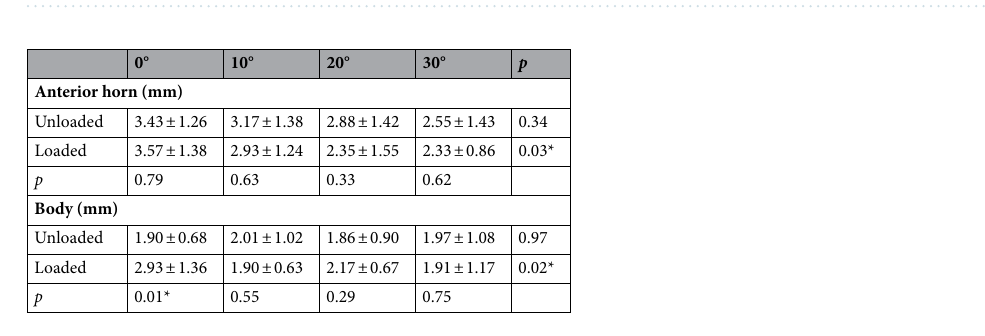
Figure 3. The general change color maps of a subject in Geomagic Qualify software 13.0 (Geomagic, Research Triangle Park, NC, USA). The scale bar in the right was applied to all the color maps with the unit in millimeters.